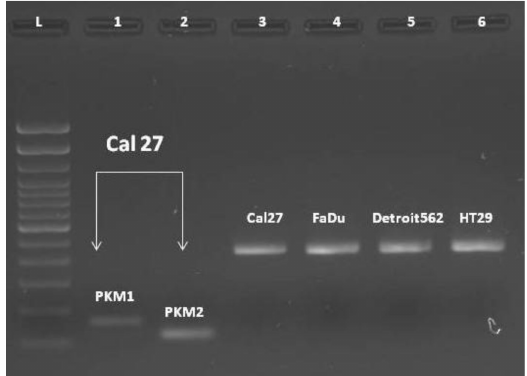
Figure 3. Presence of PKM1 and PKM2 isoforms in Cal 27; separately amplified (lines 1 and 2). Fragments obtained with PKM(C)F and PKM(C)R for obtaining the material for the RFLP analysis (lines 3–6). L: DNA